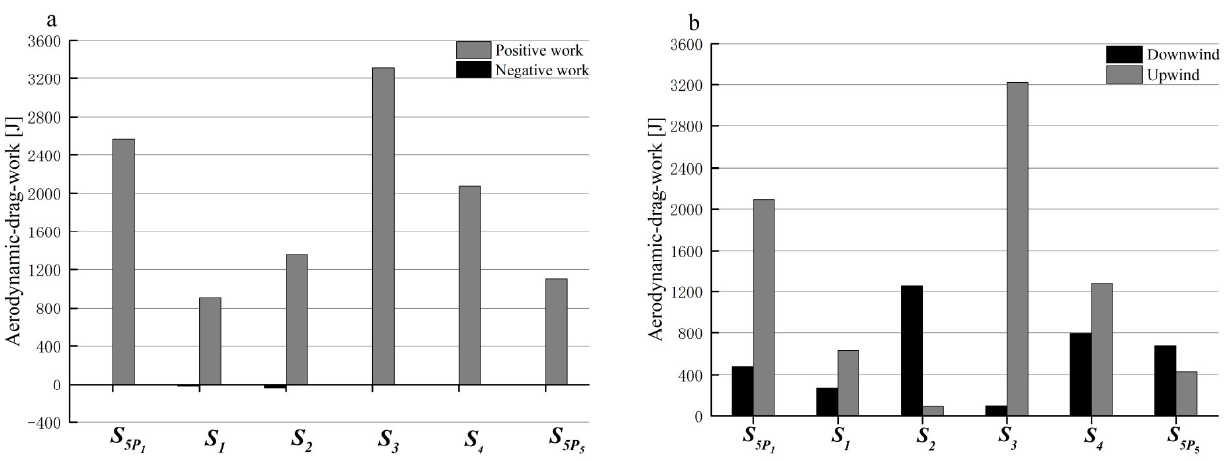
Figure 9. ( a ) The situation of overcoming aerodynamic drag to do positive work and negative work in each stage. ( b ) Work to overcome aerodynamic drag in the downwind and upwind conditions of each stage.